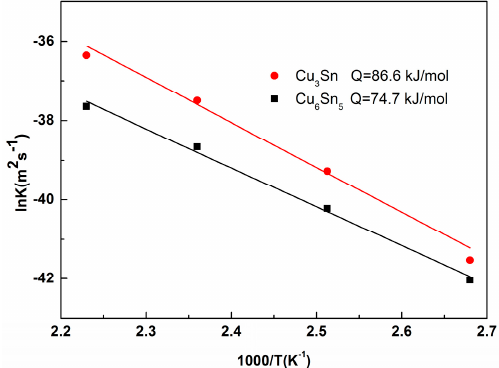
Figure 10. Arrhenius plot of the IMC layer growth during isothermal aging.